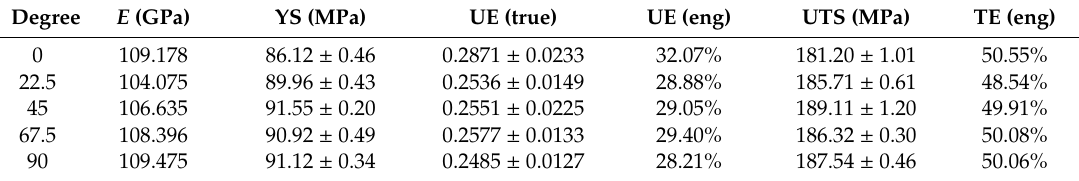
Table 2. Measured elastic and plastic properties of the niobium sheet.